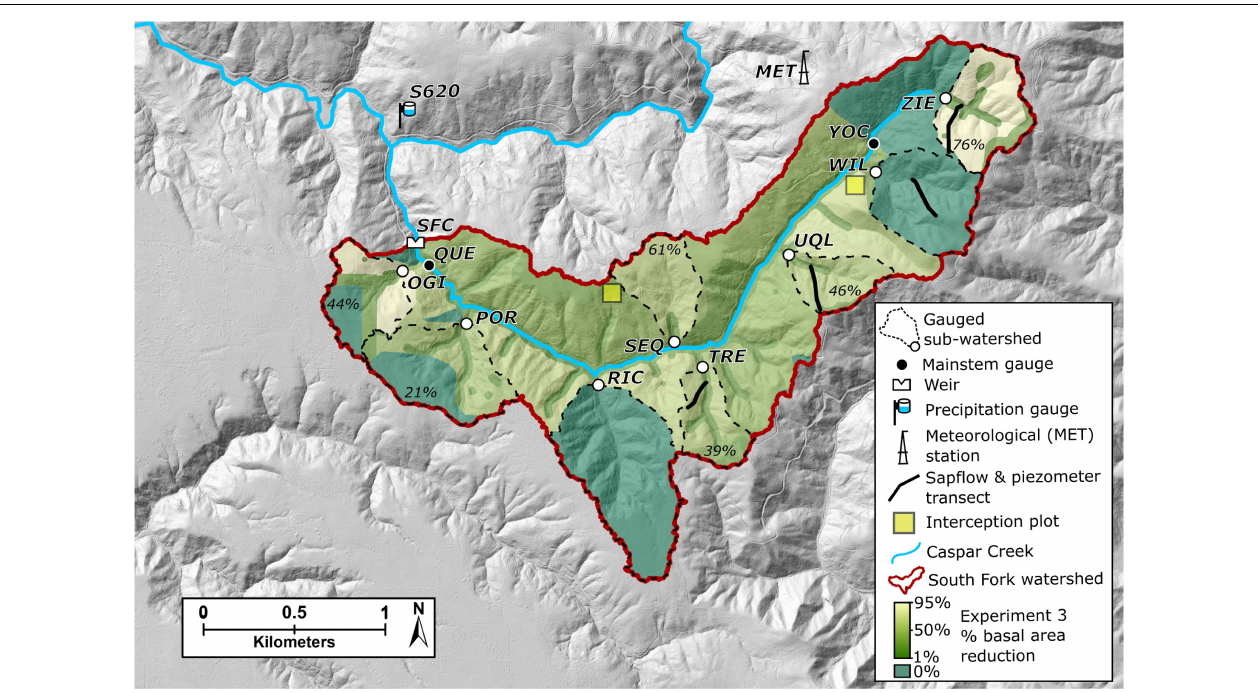
FIGURE 3 | Shaded relief map of the South Fork watershed showing study locations and harvest results for the Third Experiment. Mean percentage of basal area reduction from the timber harvest is noted for harvested, gaged sub-watersheds. The shaded relief map was created from LiDAR data collected in 2017 gridded to 1-m horizontal